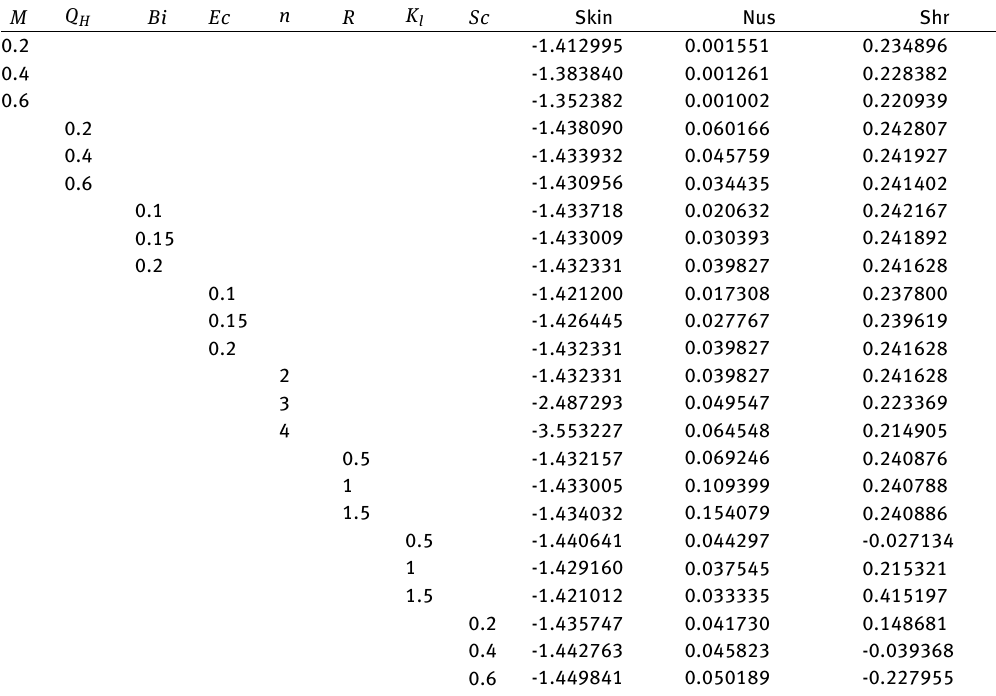
Table 1: The variations of local skin friction, Nusselt and Sherwood numbers for various values of M = 0.2, K = 0.2, Gc = Gr = 0.2, N = 0.5,